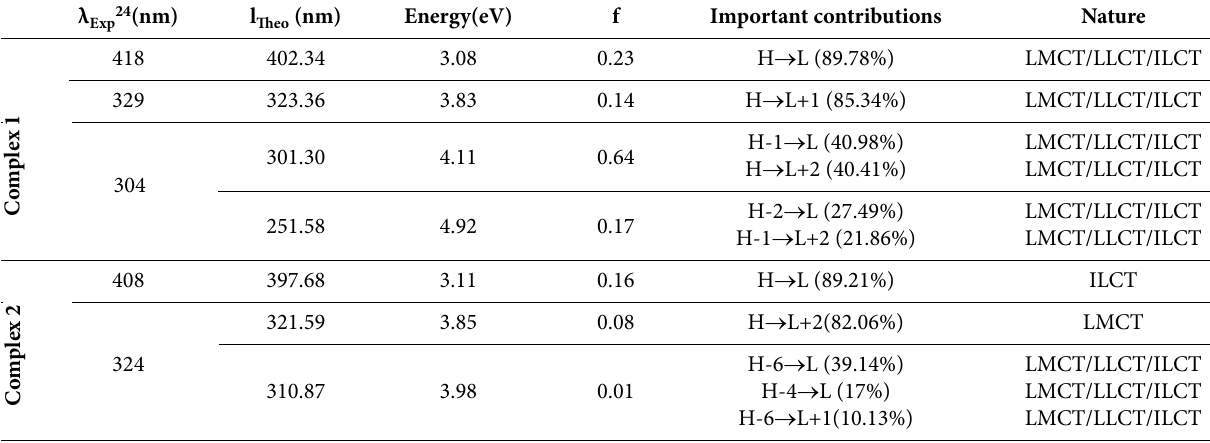
Table 3. The experimental and theoretical electronic absorption wavelengths and important contributions for Mo complexes. λ Exp24